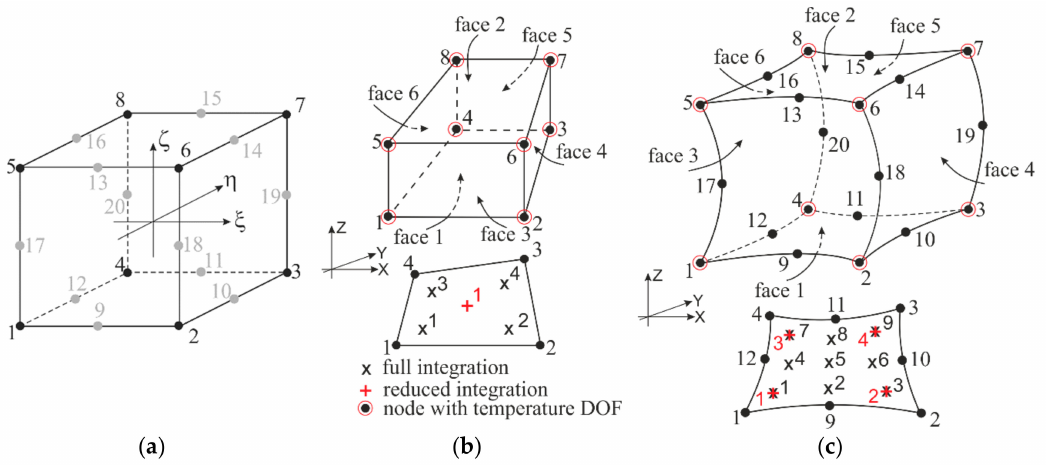
Figure 2. Isoparametric 3D brick finite elements from [56]: ( a ) master element; ( b ) eight-node linear element with reduced and full integration schemes 1 ; and ( c ) 20-node quadratic element with reduced and full integration schemes 1 . 1 Numbering of integration points for output is shown in the element layer closest to the face 1, and the integration points in the other layers are numbered